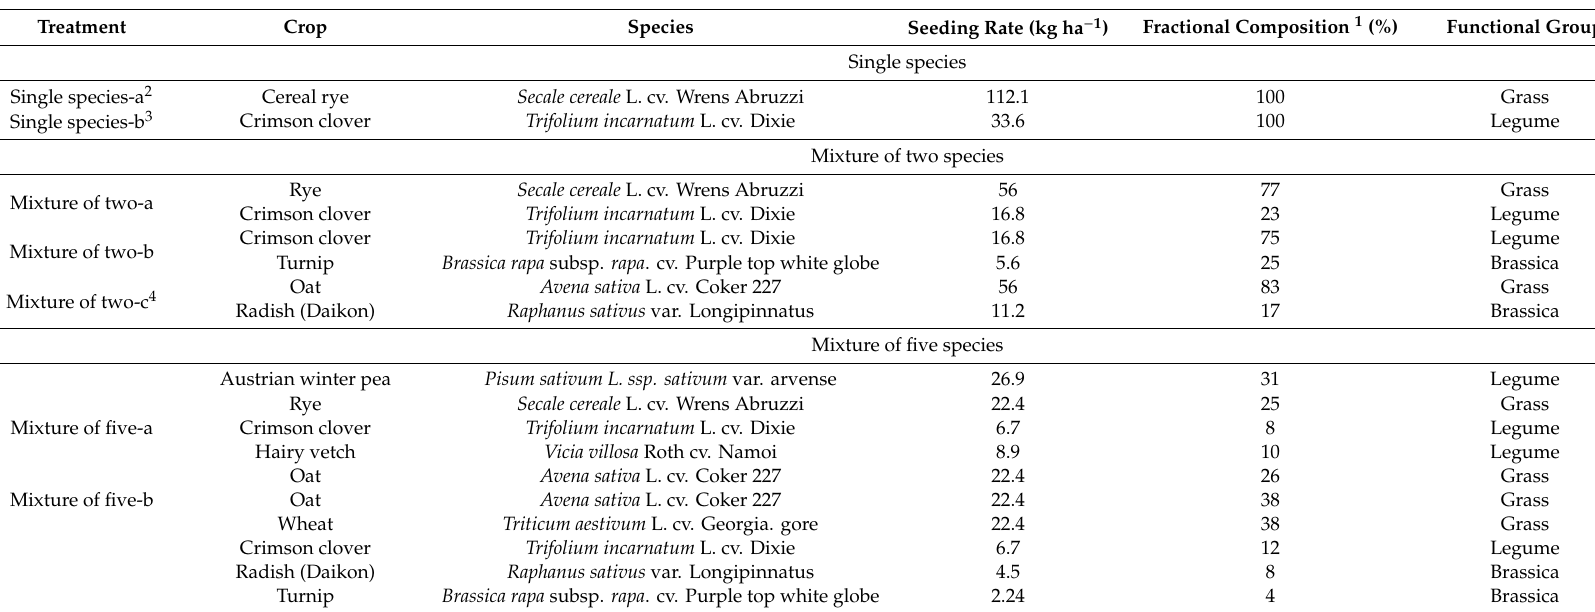
Table 2. Cover crop treatments and crops that were components of each treatment, their functional groups, seeding rate, and fractional compositions. Treatment Crop Species Seeding Rate (kg ha − 1 ) Fractional Composition 1 (%) Functional Group Single species-a 2 Cereal rye Single species-b